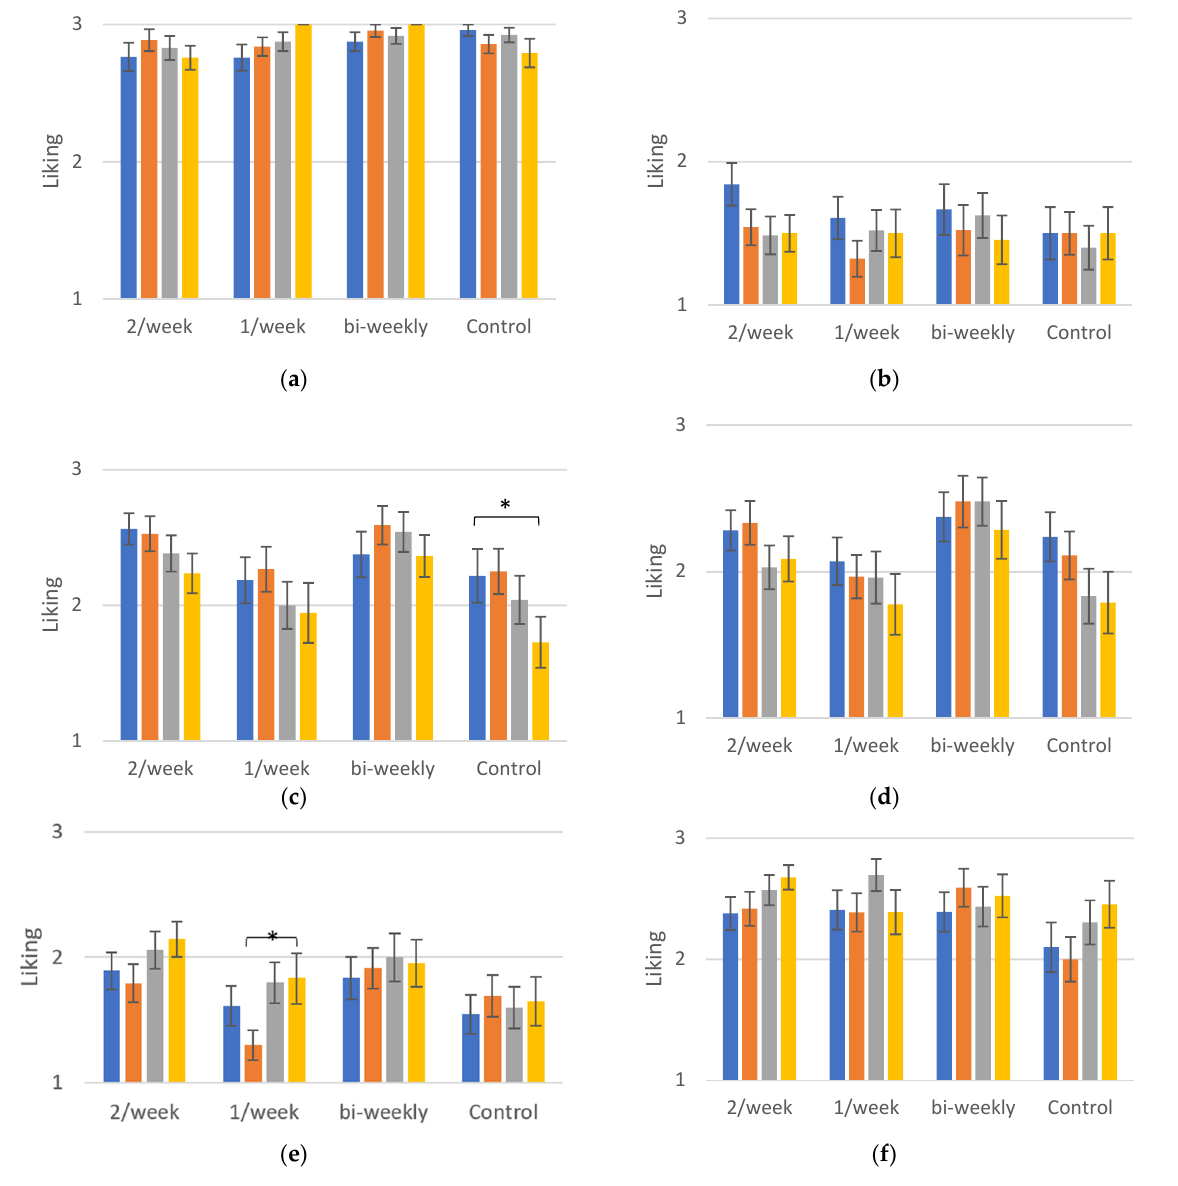
Figure 4. ( a ) Liking of cucumber for the different groups. ( b ) Liking of celery for the different groups. ( c ) Liking of broccoli for the different groups. ( d ) Liking of cauliflower for the different groups. ( e ) Liking of celeriac for the different groups. ( f ) Liking of beetroot for the different groups. Liking scores ± SEM of the different vegetables measured in control sessions for each group in order to investigate the presence of transfer effects. The significance of the differences between selected sessions is depicted for all exposure groups and vegetables. The detailed differences and their statistical significance are given in text. Significance levels: ‘*’: ≤ 0.05.